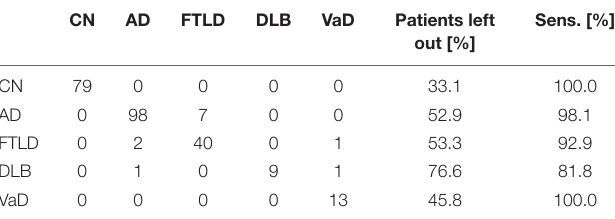
TABLE 7 | Confusion matrix (on the left), and percentage of patients left out and sensitivity for each class (on the right), when 50% of the patients that the classifier is least confident of are left